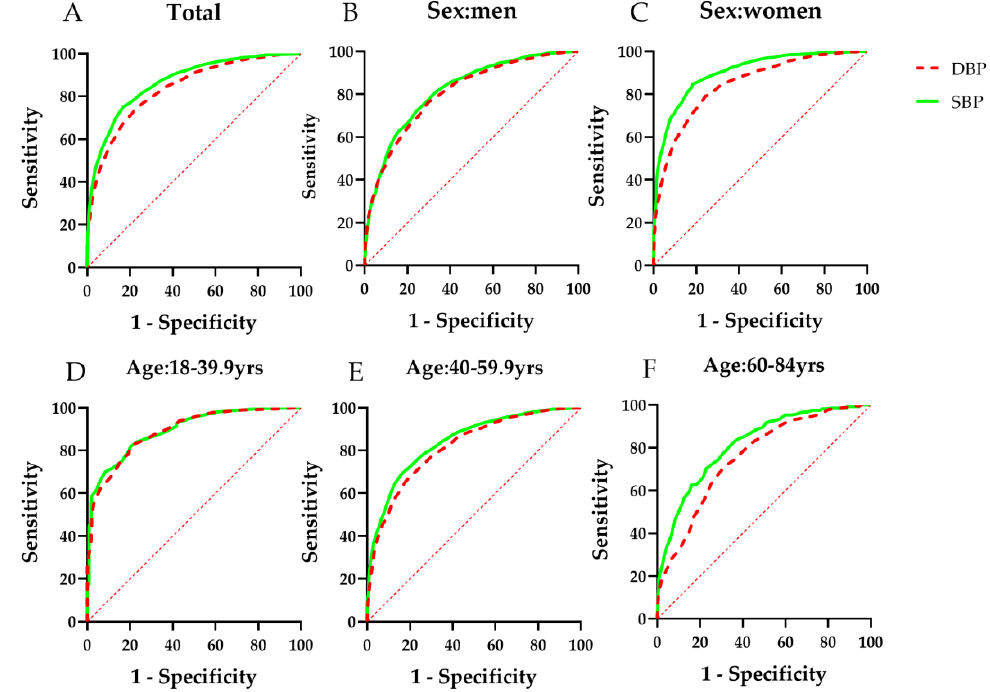
Figure 1. ROC curves of blood pressure for identifying arteriosclerosis in Chinese adults. ( A ) total subjects; ( B ) subjects in men; ( C ) subjects in women; ( D ) subjects aged 18 to 39.9 years; ( E ) subjects aged 40 to 59.9 years; ( F ) subjects aged 60 to 84 years; ROC, receiver operating characteristic; SBP, systolic blood pressure; DBP, diastolic blood pressure; yrs, years. Table 3. AUC values of sex- and age-specific blood pressure for identifying arteriosclerosis.